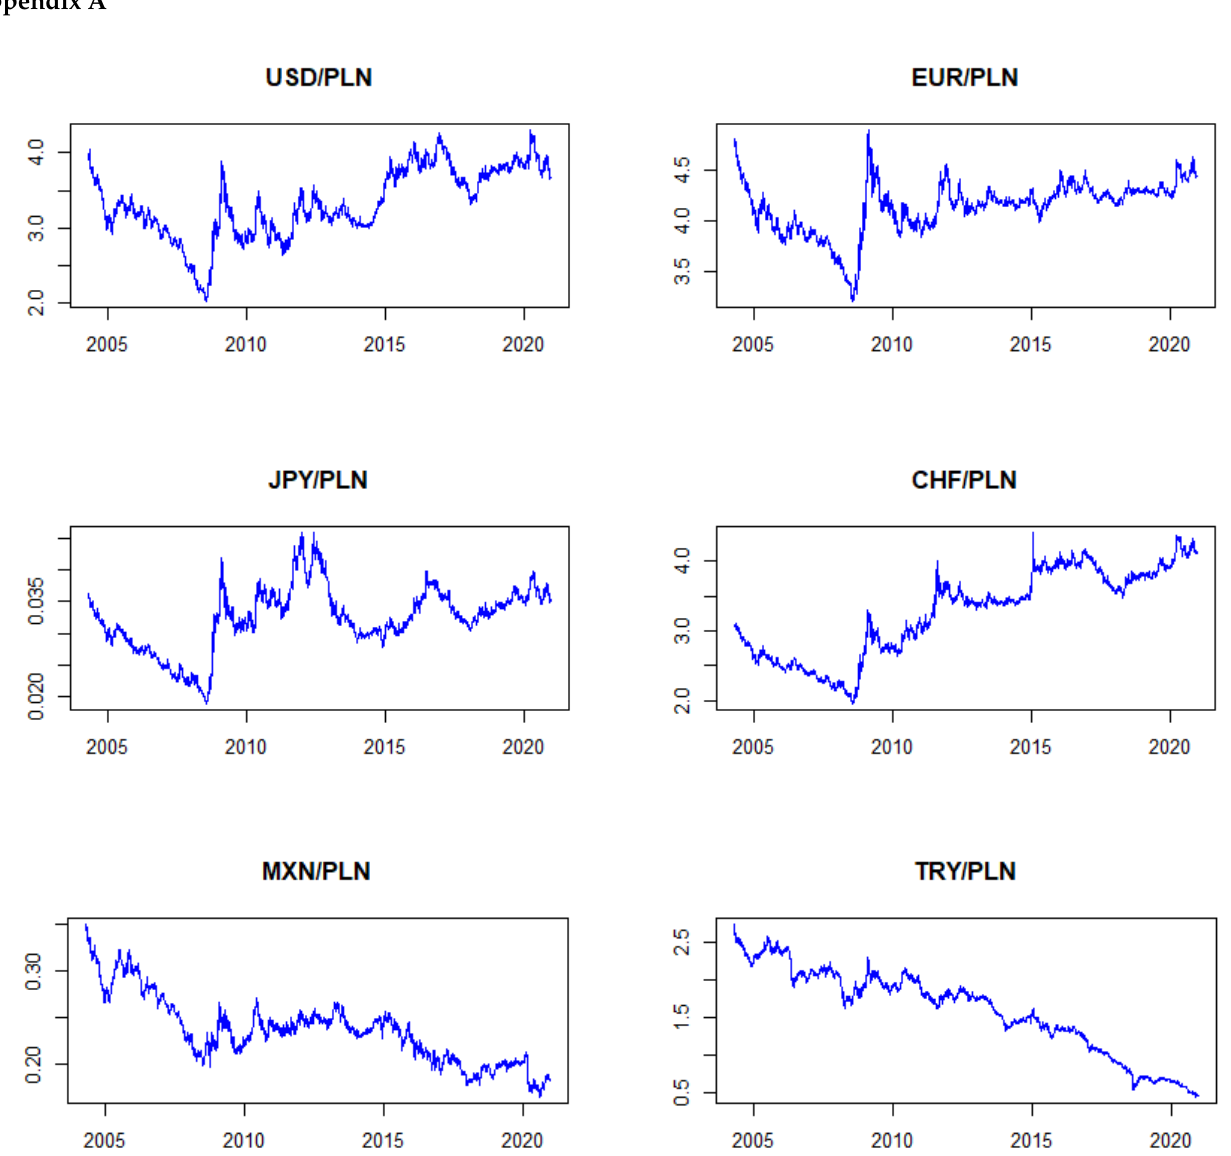
Figure A1. The Polish zloty exchange rates in the period from June 2004 till February 2021.